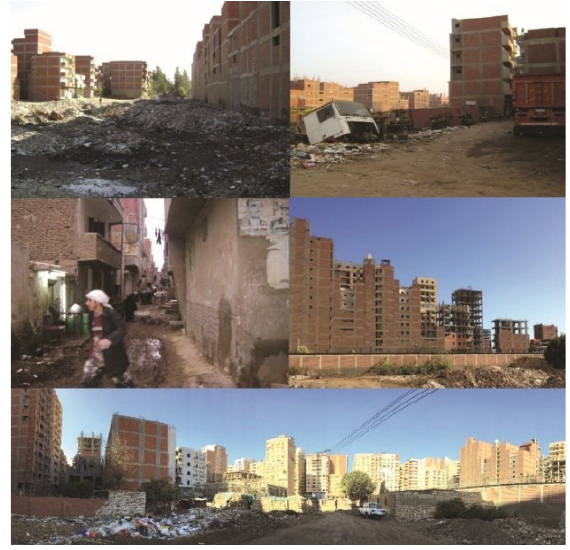
Figure 2. Illustrates some cases of